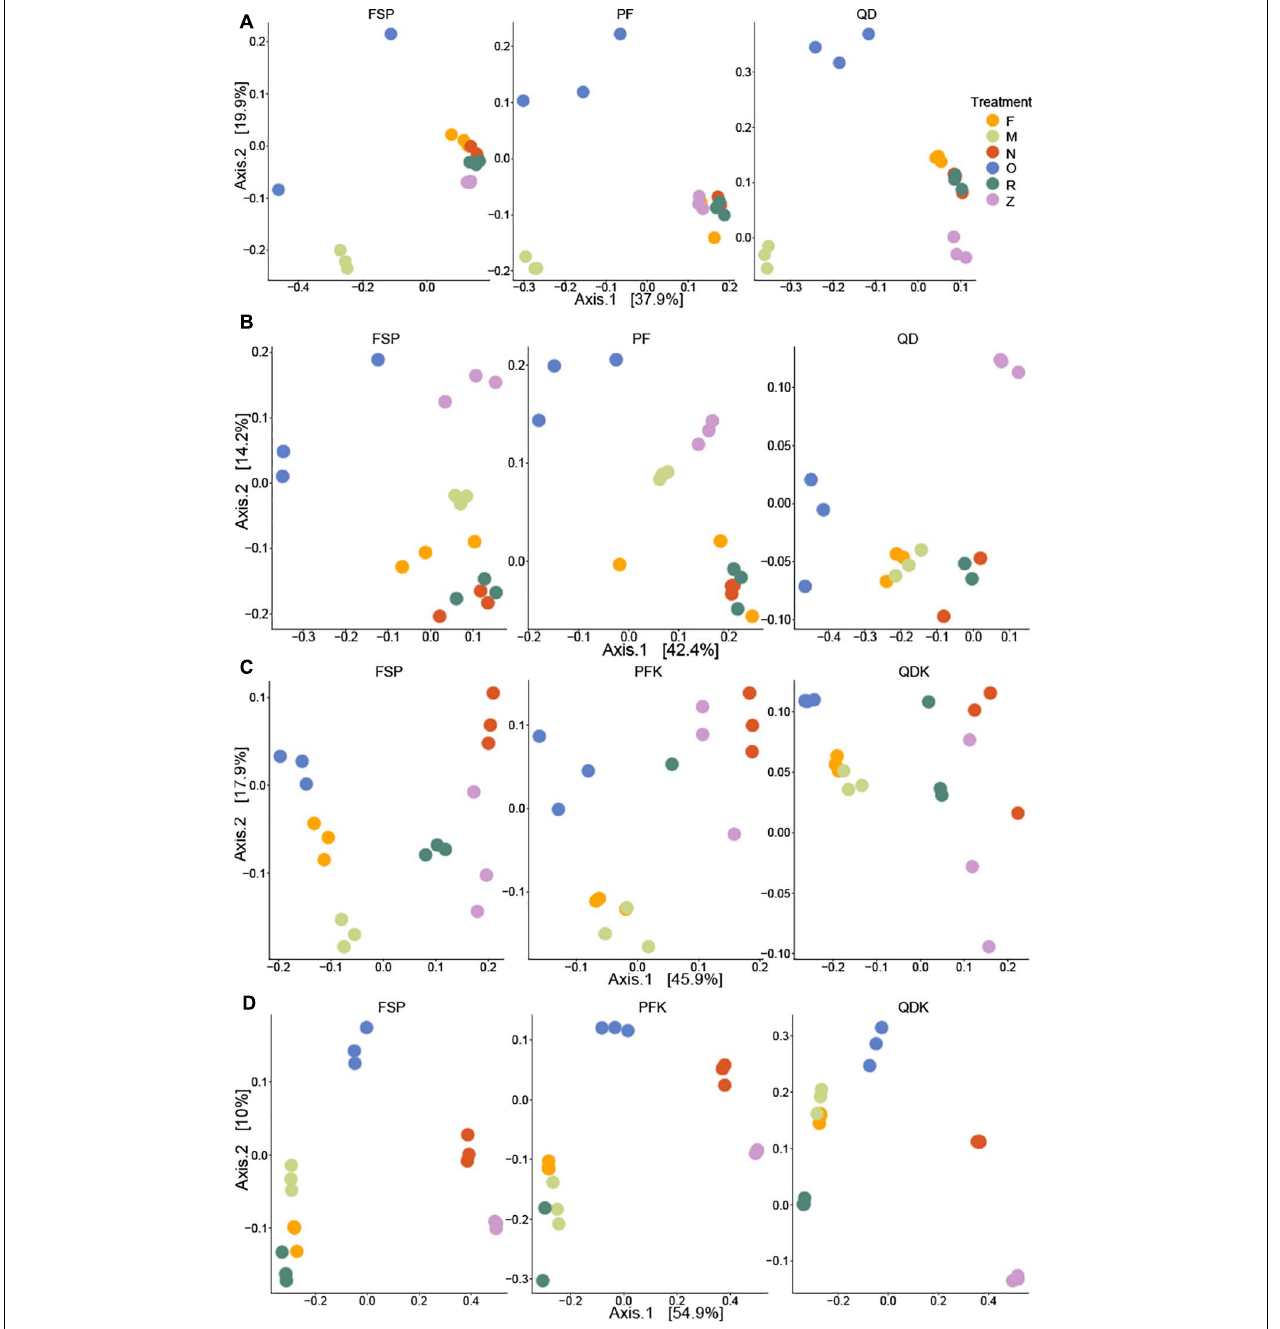
FIGURE 9 | Principal Coordinates Analysis (PCoA) of differences in beta diversity among samples. Chicken cecum (A) , chicken feces (B) , pig ileum (C) , and pig feces (D) samples. Bray–Curtis dissimilarity was used to calculate beta diversity. Each dot represents one sample and each color represents the way the sampled was stored prior to extraction by each of the three DNA extraction kits. F: freshly extracted. M: frozen at − 80 ◦ C, N: NAP buffer, O: OMNIgene-GUT buffer, R: RNALater, Z: ZYMO DNA/RNA Shield. Samples with more similar microbial community profiles cluster together, whereas those with more dissimilar microbial profiles are a further distance